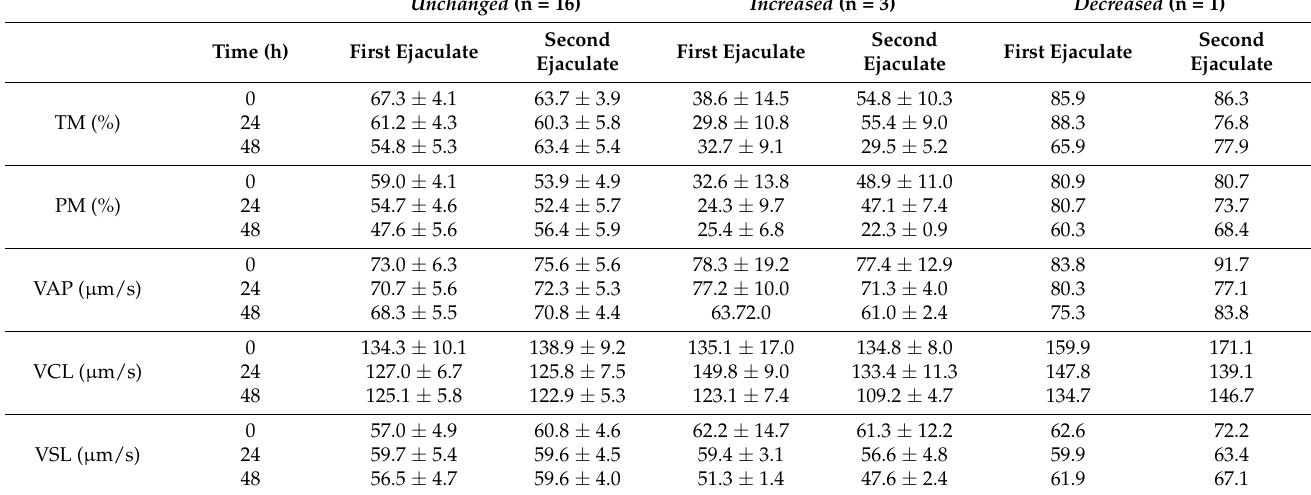
Abbreviations: TM, total motility (%); PM, progressive motility (%); VAP, average path velocity; VCL, curvilinear velocity; VSL, straight-line velocity.